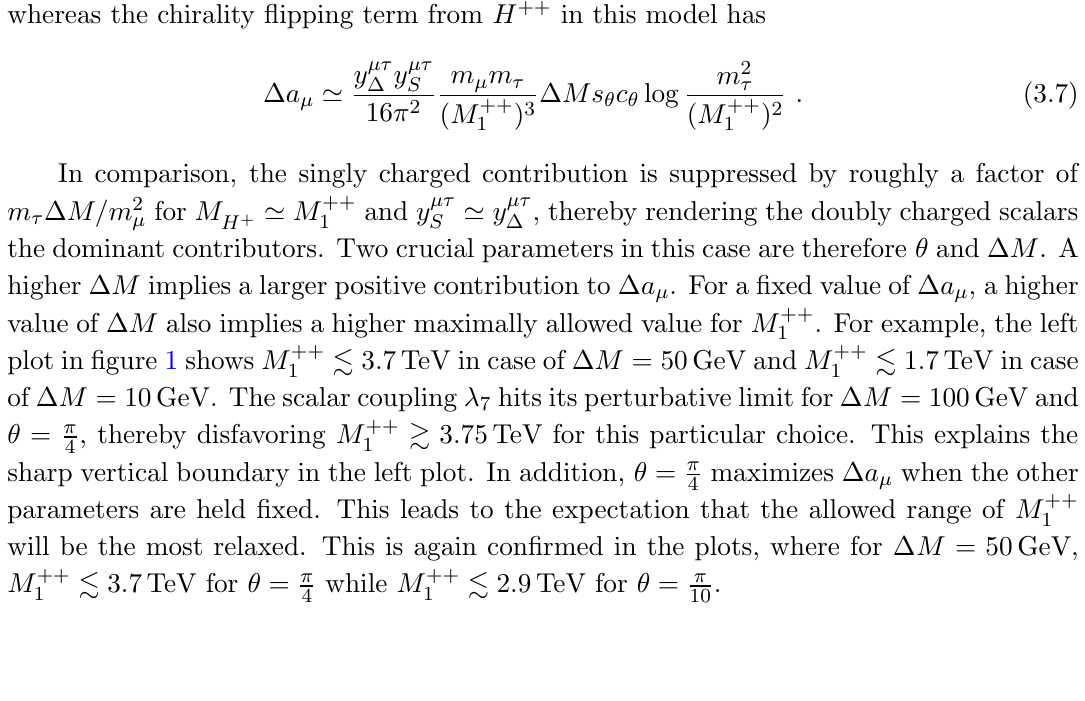
Figure 1 . The allowed parameter space maintaining (cid:1) a (cid:22) within its 2 (cid:27) range in the M ++ plane for (cid:18) = (cid:25) (left) and (cid:25) (right). The color coding is explained in the legends. The M ++ 4 10